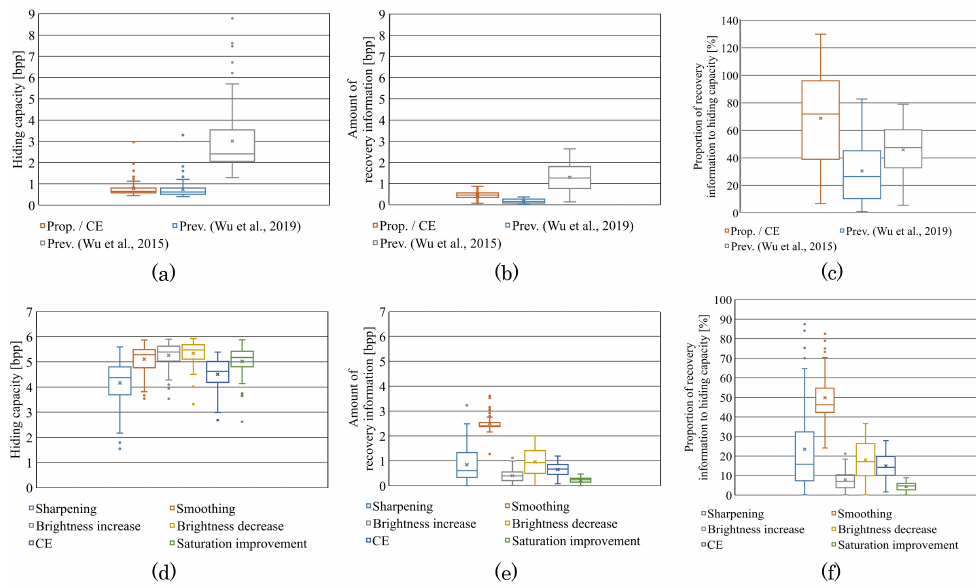
Figure 9. Performance of HS and PEE-HS methods ( I VSH = I VSM = 2, I VI = I VD = I VC = 30, and I S = 20). ( a ) Hiding capacity (HS) for proposed and previous methods [1,12]. ( b ) Amount of recovery information (HS) for proposed and previous methods [1,12]. ( c ) Proportion of recovery information to hiding capacity (HS) for proposed and previous methods [1,12]. ( d ) Hiding capacity (PEE-HS). ( e ) Amount of recovery information (PEE-HS). ( f ) Proportion of recovery information to hiding capacity